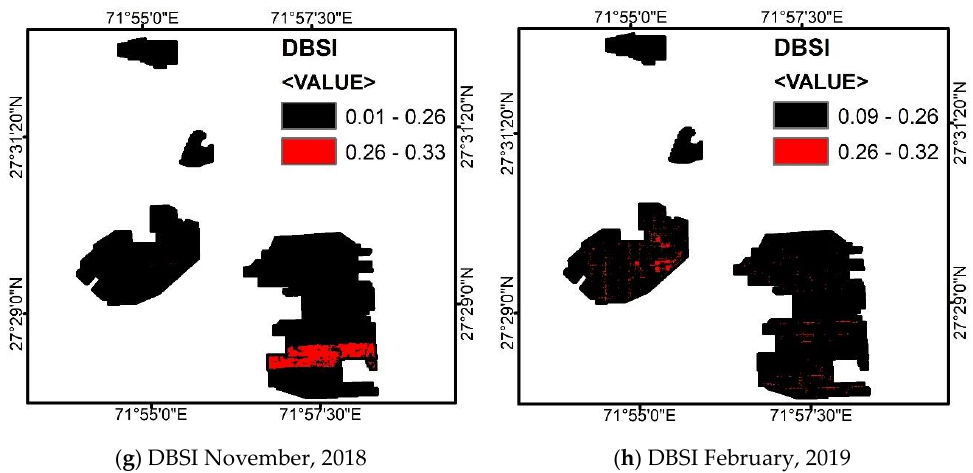
Figure 9. Sentinel-2 Spatial distribution of soiling patterns using dry bare soil index (DBSI) at different times after the installation of panels. Images highlight the affected area that is distinguished by applying threshold value. Figure 9( a ), 9( b ), 9( c ), 9( d ) show high soiling compared to Figure 9( e ), 9( f ), 9( g ), 9( h ).